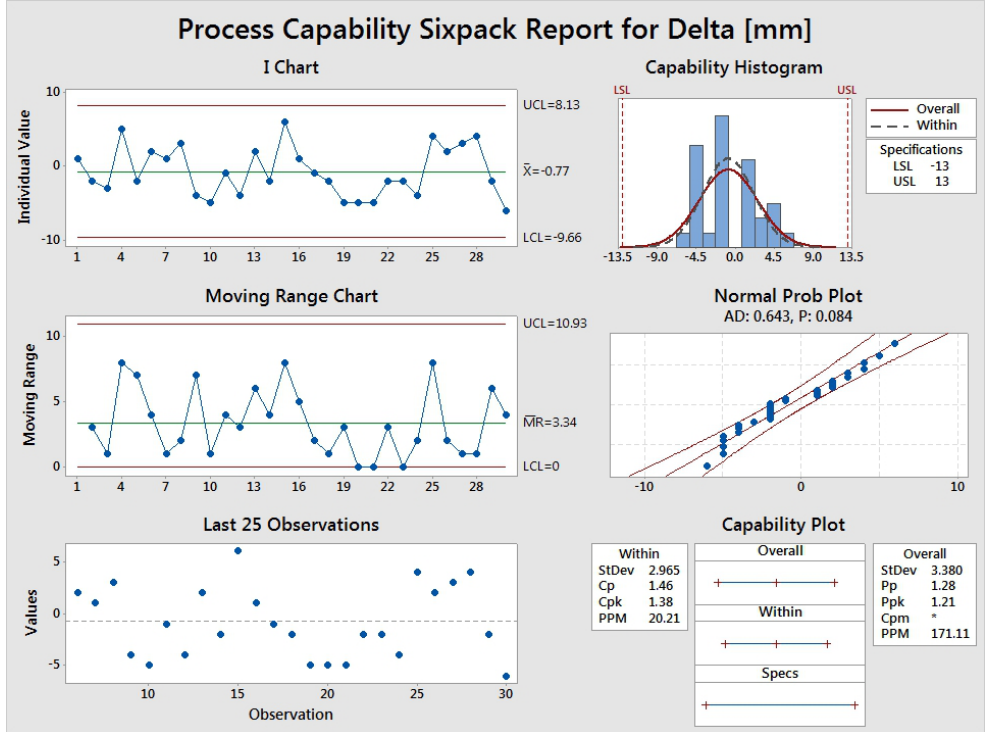
Figure 6. Capability analysis for the actual distance and distance computed by the method using video